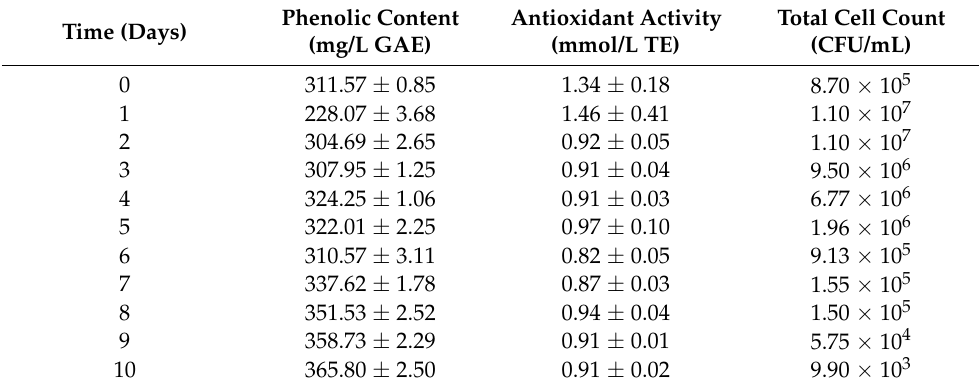
Table 4. Total phenolic content, total antioxidant activity, and total plate count of the ratio of fresh pineapple juice to water at 2:1 during wine